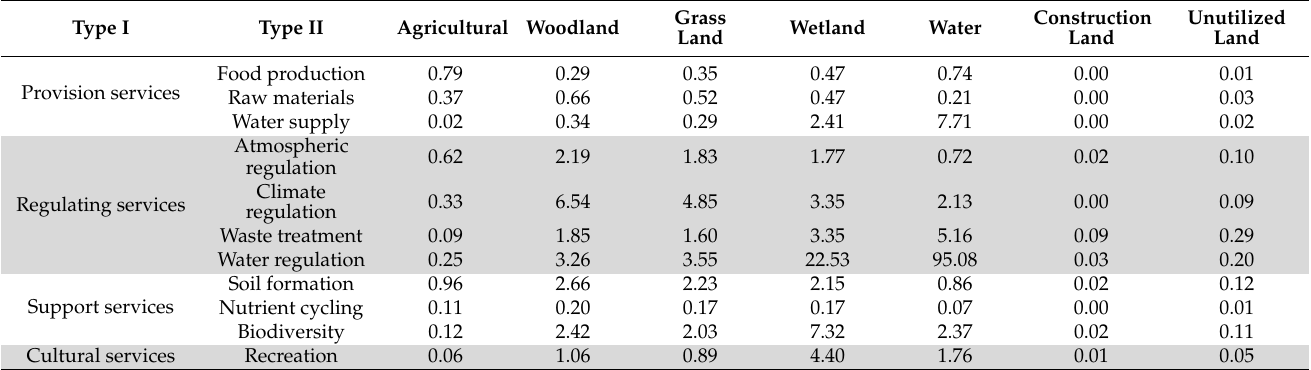
Table 1. The equivalence coefficients of ESs per unit area.